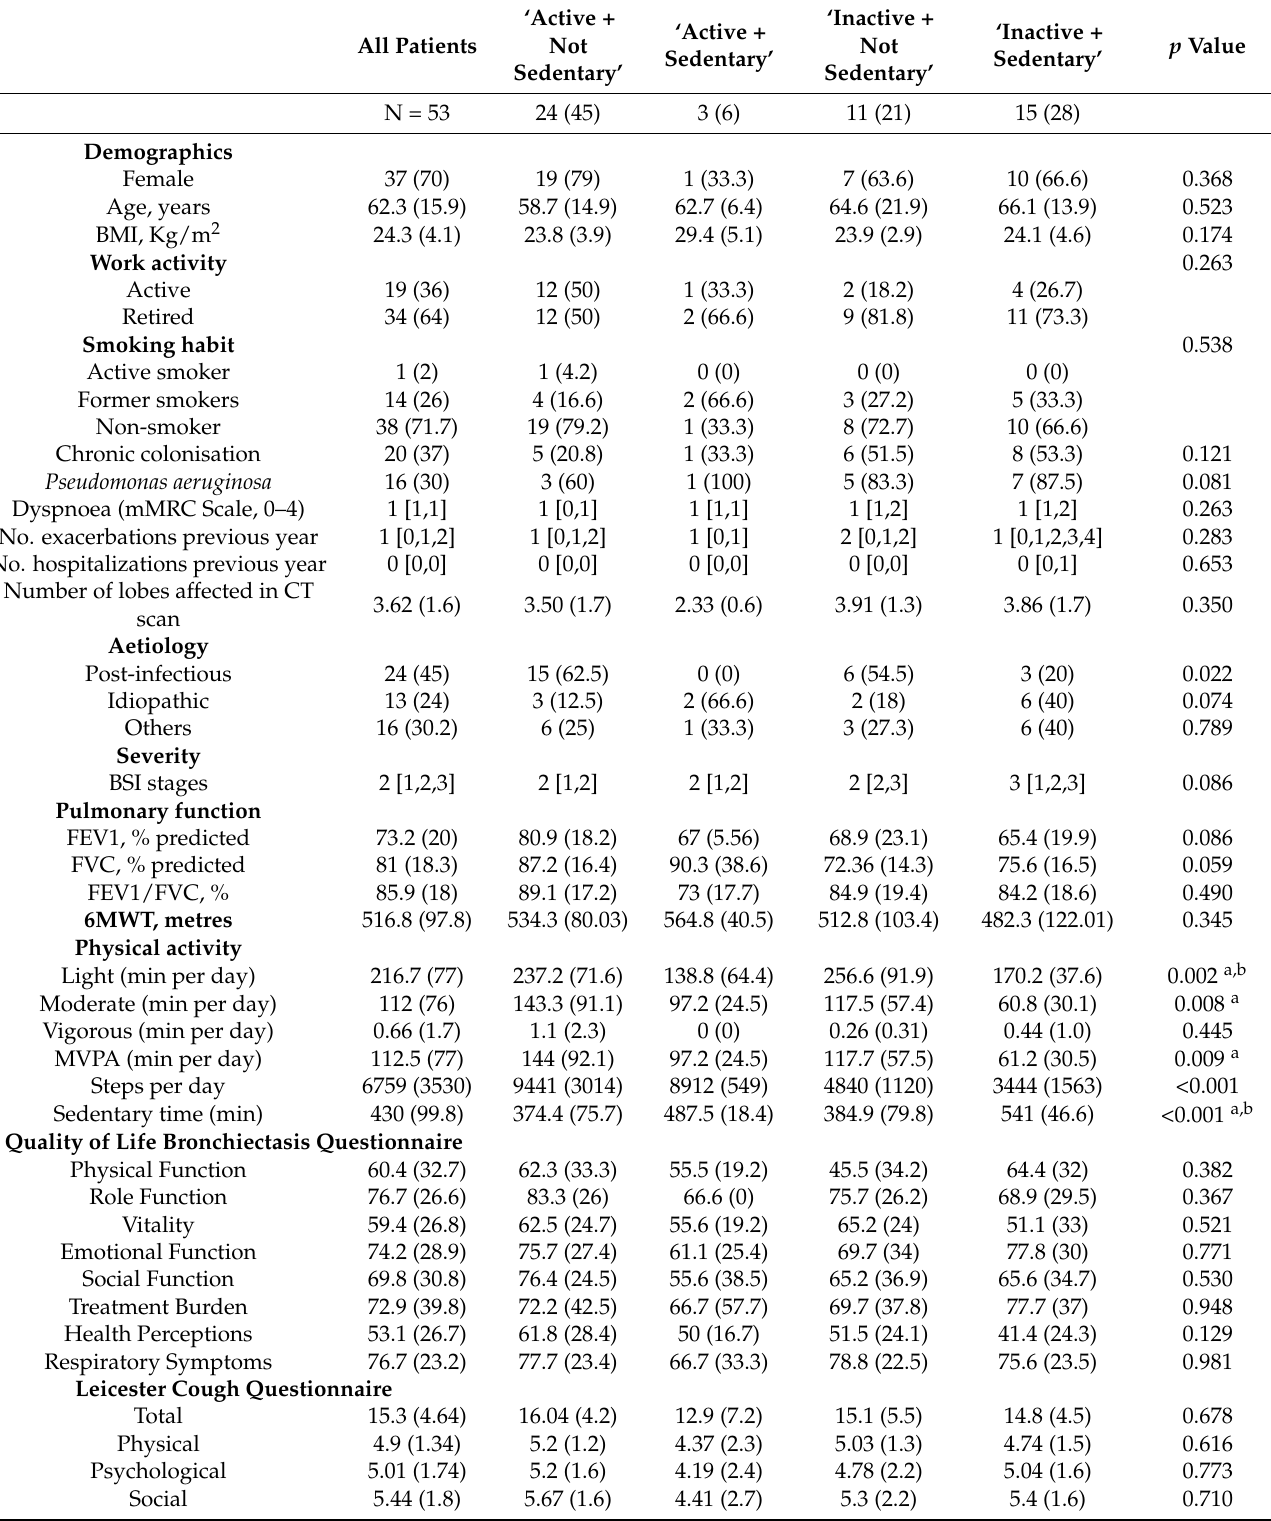
Table 1. Baseline characteristics by physical activity and sedentary behaviour